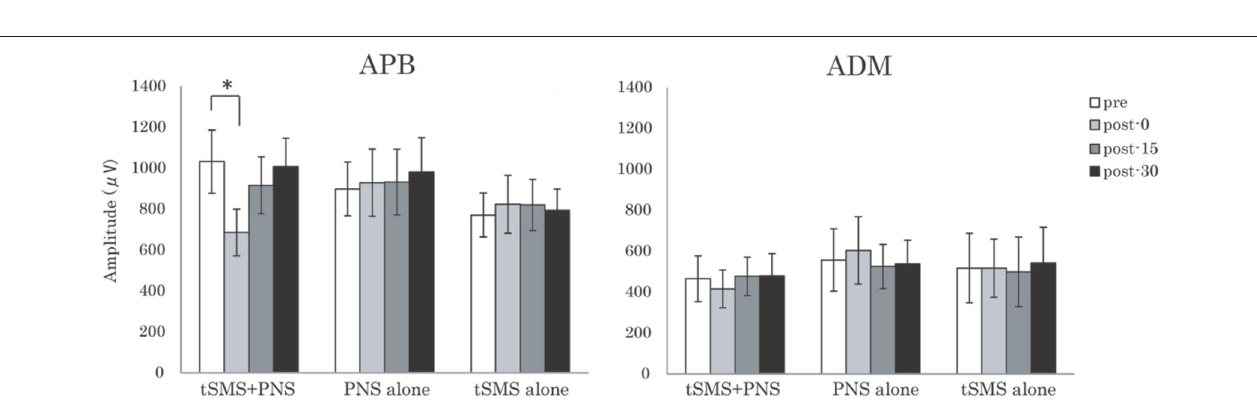
FIGURE 1 | Healthy volunteers received peripheral nerve stimulation on right median nerve combined with transcranial statistic magnetic stimulation (tSMS) over left M1 or sham stimulation. We recorded the motor evoked potential (MEP) from the right abductor pollicis brevis (APB) and abductor digiti minimi (ADM) muscles to assess change in corticospinal and intracortical excitability immediately before and after 5min of intervention. In each block, we assessed the resting motor threshold (rMT), short-latency intracortical inhibition (SICI) at an interstimulus interval (ISI) of 3 ms and intracortical facilitation (ICF) at an ISI of 12 ms. Evaluation was done just before, immediately, 15min, and 30min after intervention.